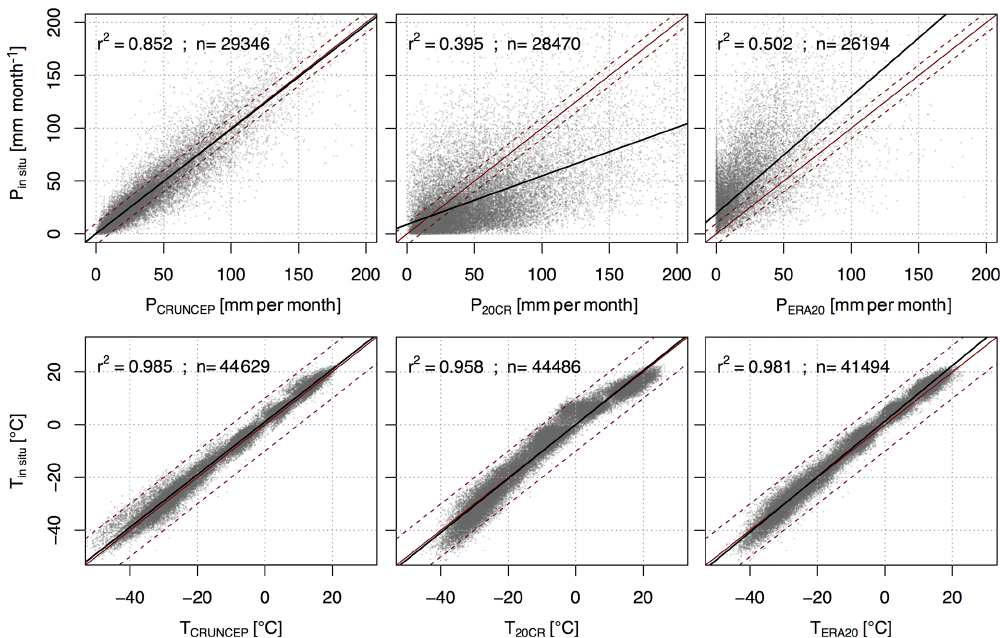
Figure 5. Comparison of three reanalysis datasets with in situ records (RIHMI-WDC) for monthly values. Red solid line is the 1 : 1 line; red dashed line is ± 10mm for precipitation and ± 10 ◦ C for temperatures.